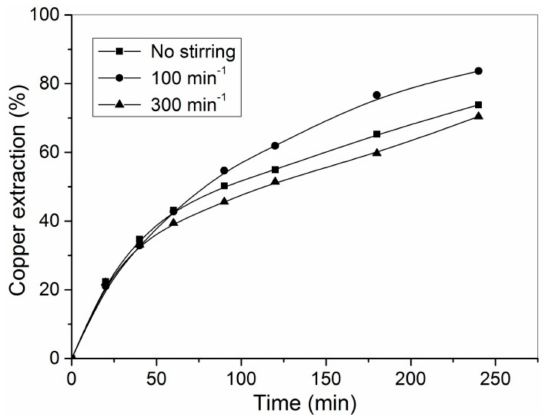
Figure 5. Influence of the stirring speed on copper extraction yield (temperature—40 ◦ C, particle size –37 µ m, solid / liquid ratio—2 g / dm 3 , 1.5 M H 2 SO 4 , 1 M H 2 O 2